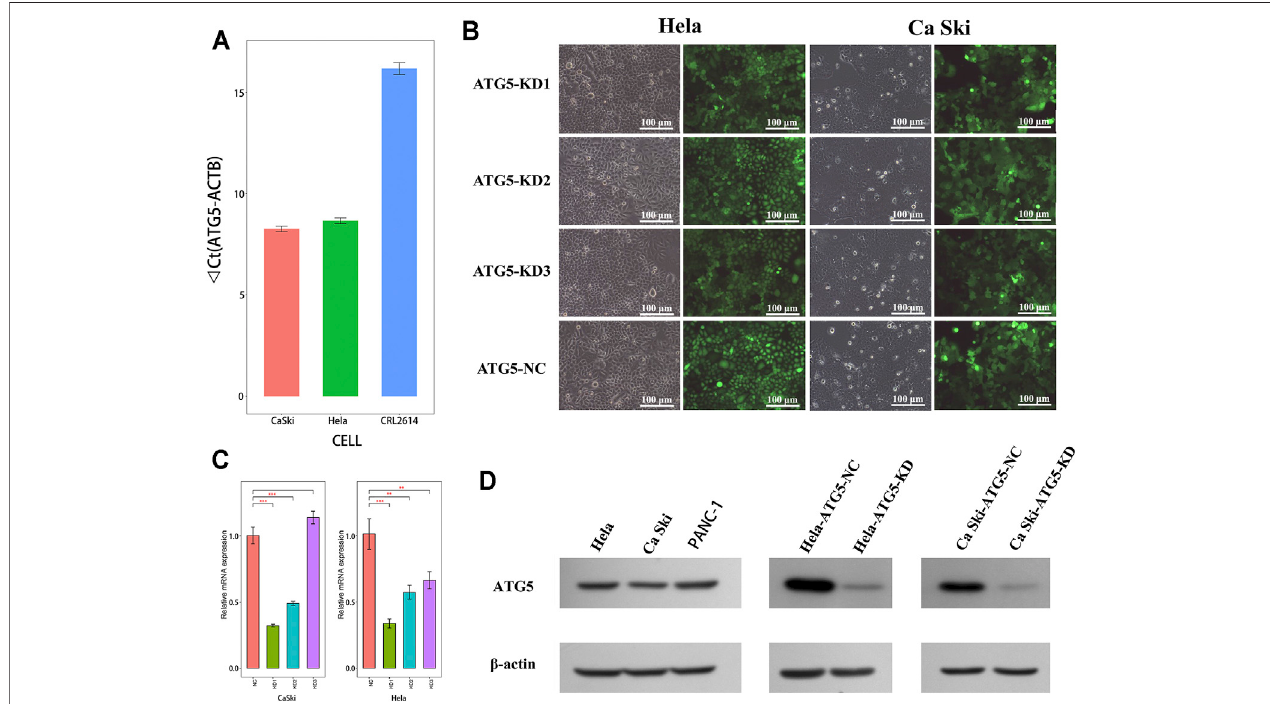
FIGURE 8 | Expression of ATG5 in cervical cancer cell lines (A) The expression of ATG5 mRNA was detected in Hela and Ca Ski (B) After 72 h infection, Hela and CaSkicellswithgreen fl uorescencewerethecellsthattransfectedplasmidsuccessfully.Magni fi cation × 100 (C) mRNAexpressionofATG5wassigni fi cantlyinhibitedby ATG5-RNAicomparedwiththecontrolgroup.Errorbarsrepresent ± SD.* p < 0.05,** p < 0.01,*** p < 0.001 (D) ProteinexpressionofATG5couldbedetectedinHelaand CaSki,andwassigni fi cantlydownregulatedbyATG5-RNAiinHela-ATG5-KDandCaSki-ATG5-KDcellscomparedwiththecontrolgroup.PANC-1wasusedasa positive